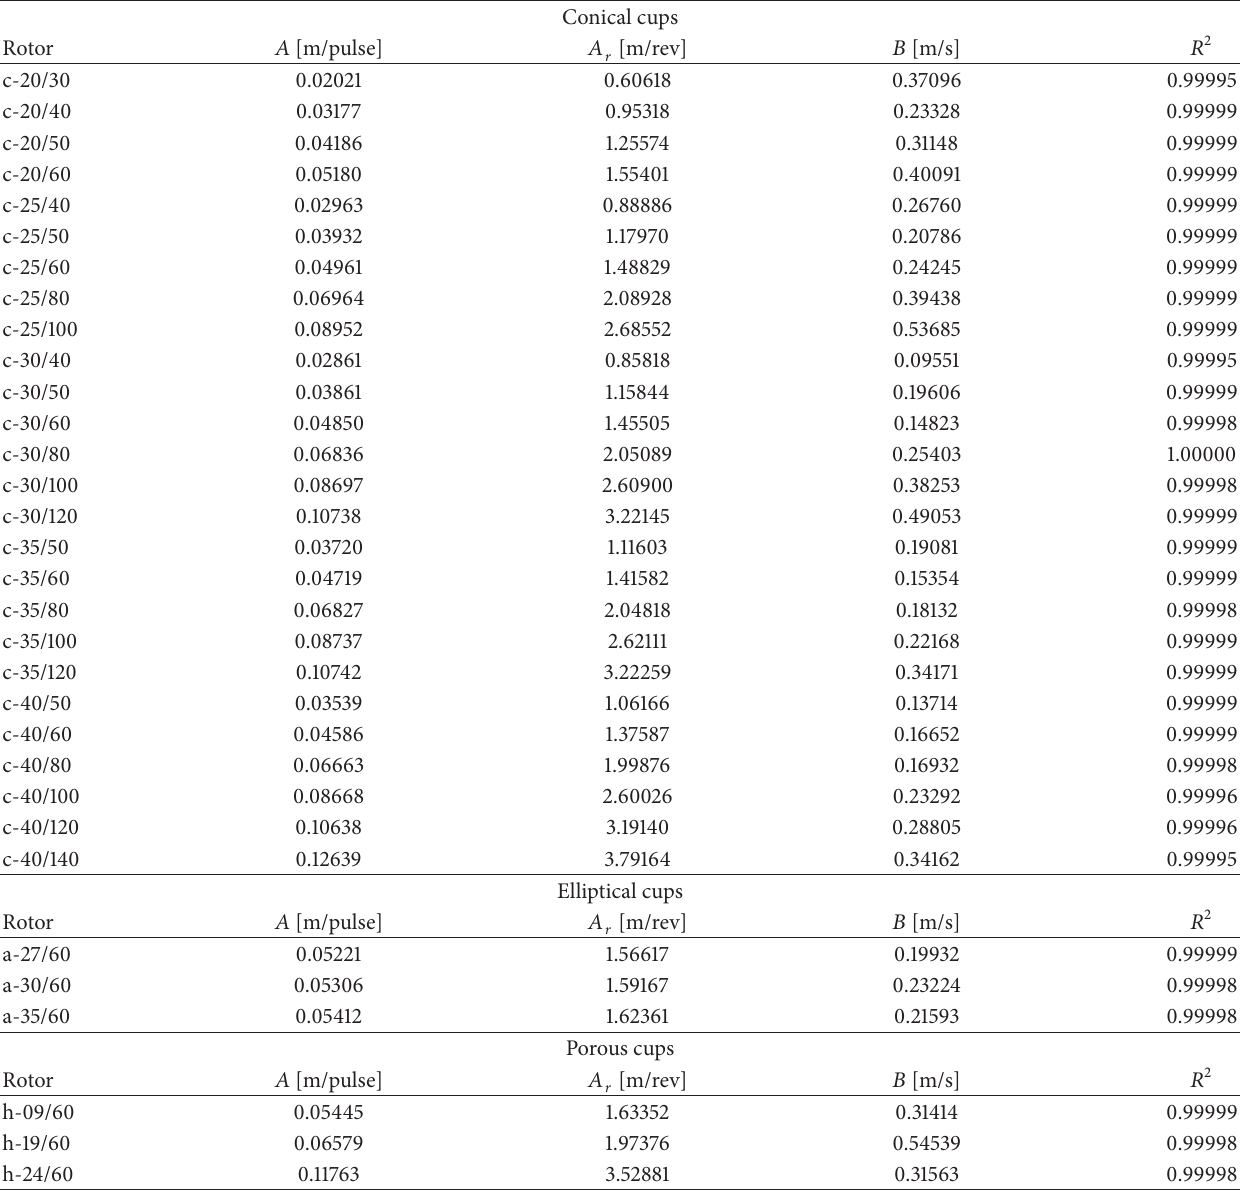
Table 3: Calibration coefficients, 𝐴 and 𝐵 , measured for the rotors tested with Climatronics 100075 anemometer (see also Table 2 and Figure 2). The coefficient of determination, 𝑅 2 , of the curve fittings, and the slope of the transfer function based on the rotation frequency, 𝐴 𝑟 (see expressions (1) and (2)), have also been